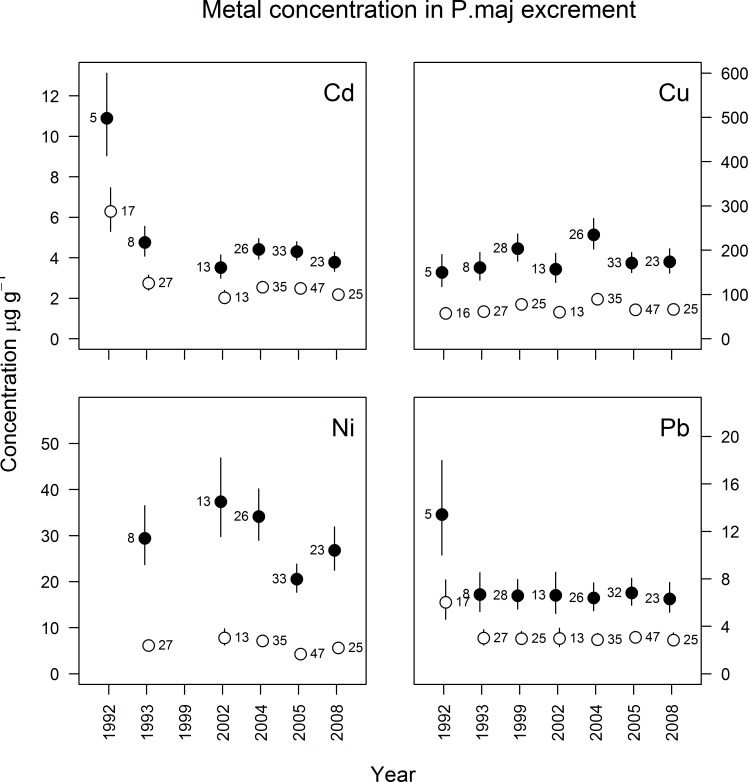
Metal concentration (μg g-1 dw, geometric mean ± 95% confidence limit) in excrement of great tit (Parus major) nestlingssampled between 1992 and 2008 from polluted (black dots, ≤ 2 km from the smelter) and reference areas (open dots, > 4 km from the smelter). Numbers denote sample size.